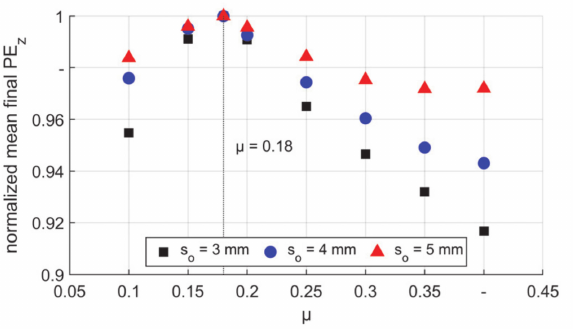
Figure 22. Final values of mean axial PE z , normalized values to µ =